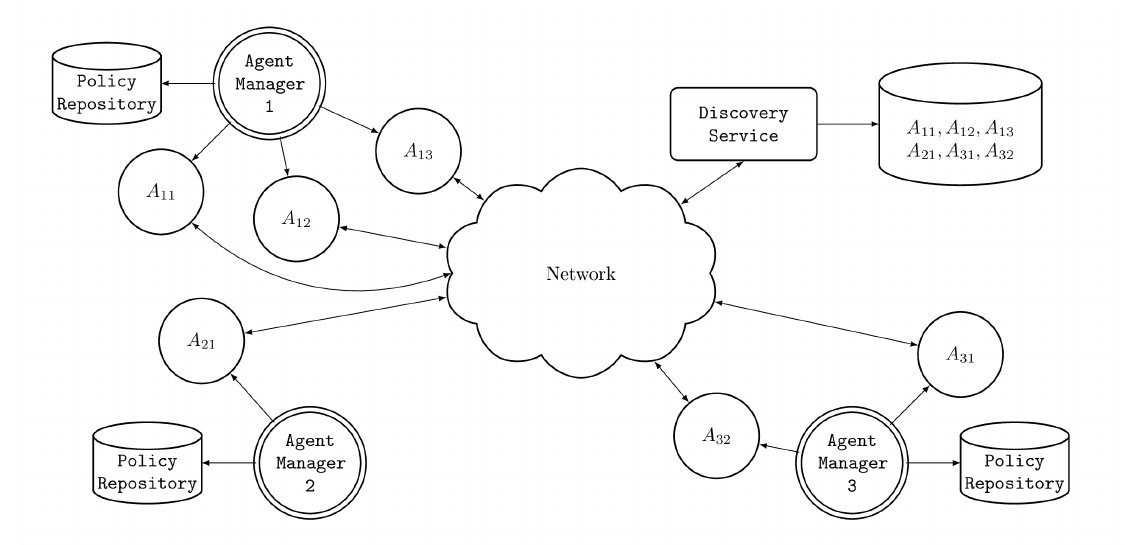
Figure 3. Architecture of the ARPS